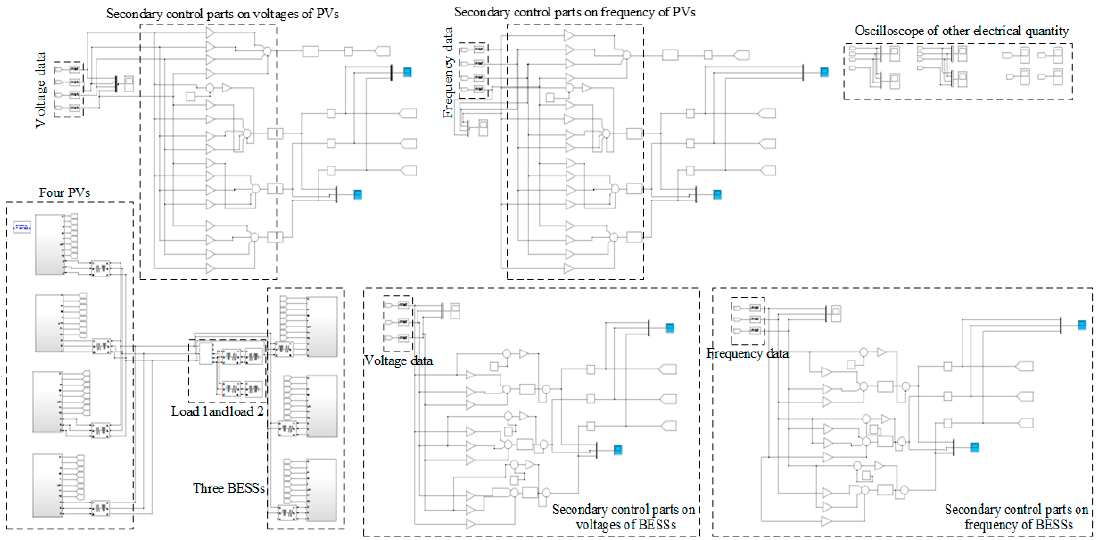
Figure A1. The related Simulink model to experiments.